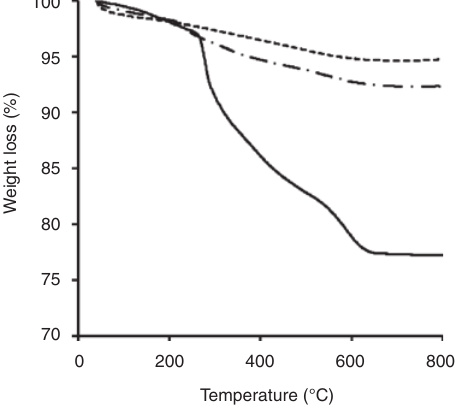
Figure 6: Thermal gravimetric analyses (TGA) curves of porous nanosilica (PNS) (square dot line), PNSC (long dast dot line), and adamantylamine-polyethylene glycol-functioned cyclodextrin- porous nanosilica (PNSC@APEG) (solid line). respectively. In vitro release profile of 5-FU from PNSC@ APEG was performed in order to evaluate the stability and release behavior of particles (Figure 7A). As